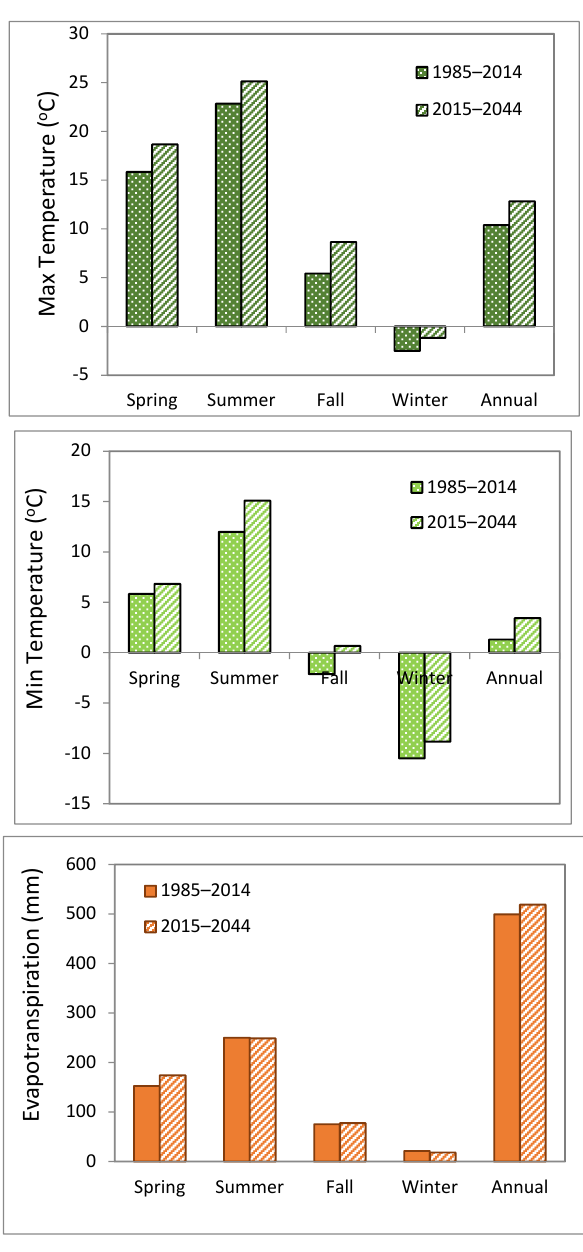
Figure 4. Historical and future seasonal precipitation, evapotranspiration and temperature.